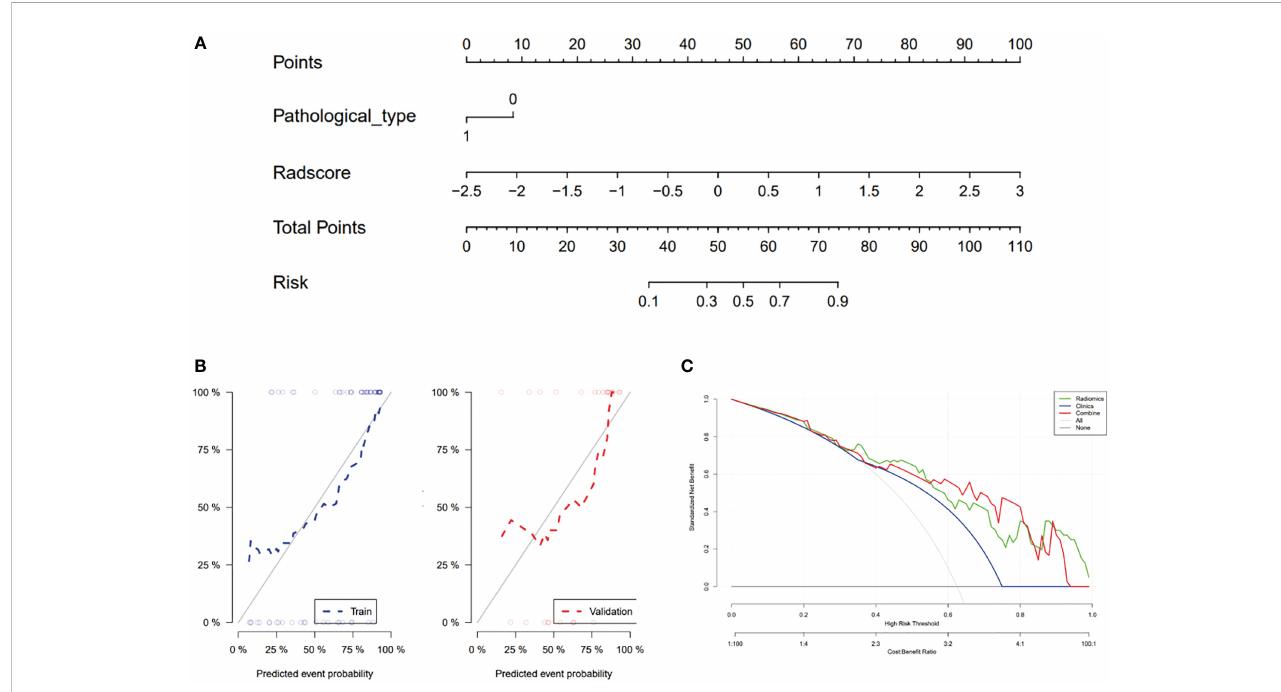
FIGURE 4 Nomogram, Calibration curve and Decision curve analysis. (A) Nomogram and (B) Calibration curve for Major Pathological Response in the training and validation groups. (C) Decision curve analysis for each model (clinical (Clinics) model, radiomics (Radiomics) model, and integrated (combined)